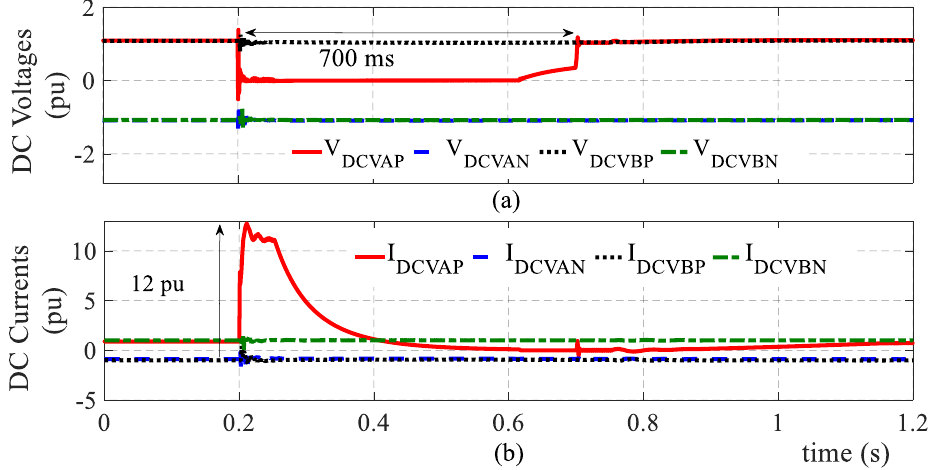
Figure 18. DC side measurements at VSC stations during a P-Pole-to-ground fault on VSC branch-A ( a ) voltages, ( b ) currents.